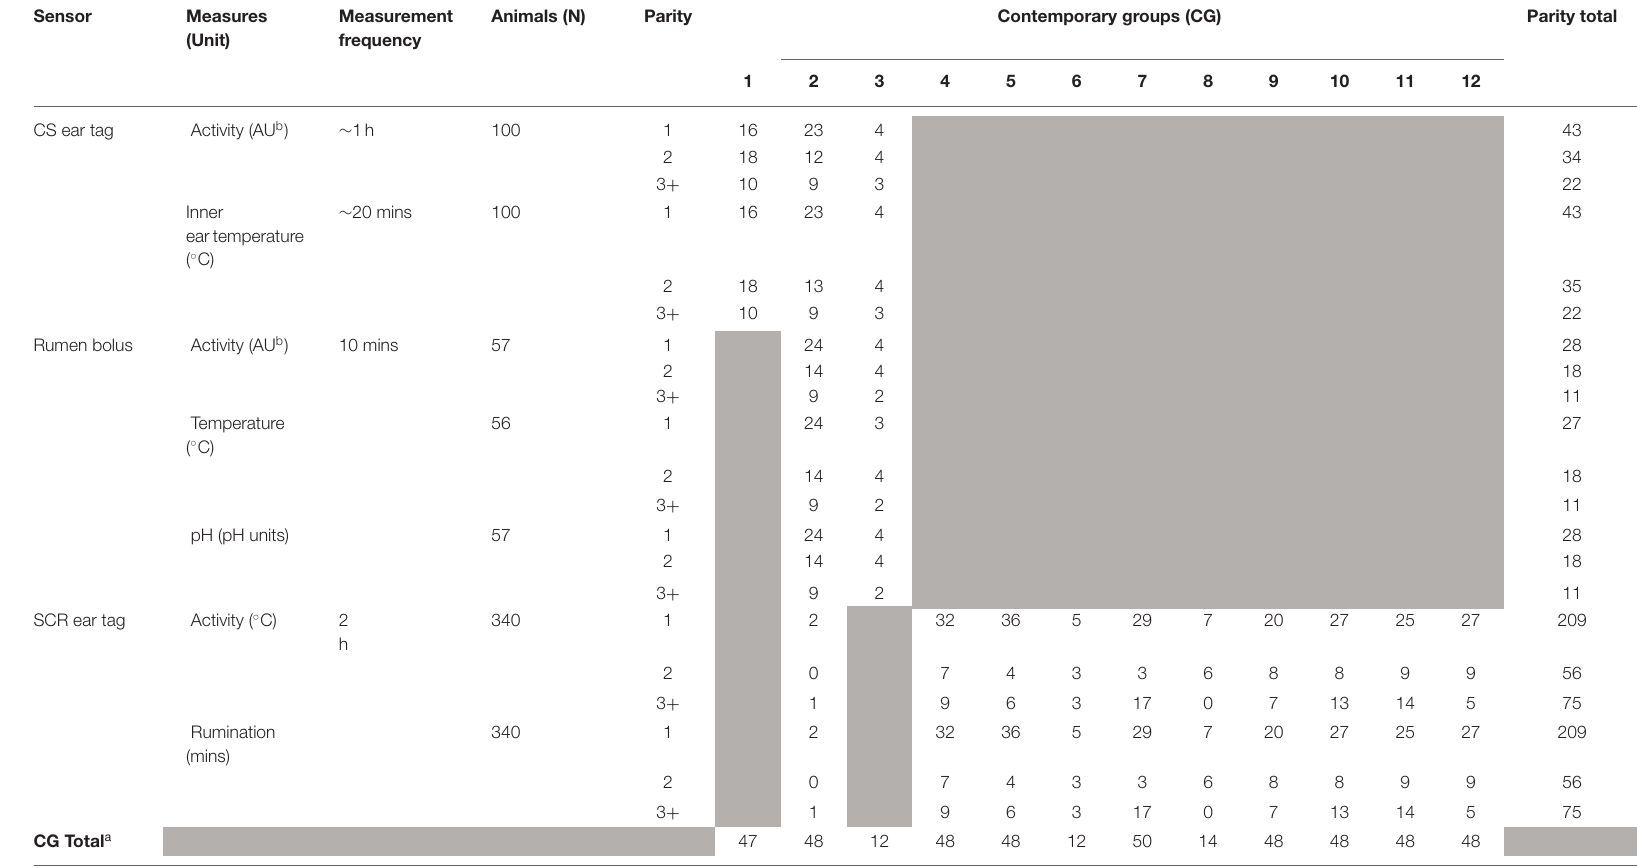
TABLE 1 | Summary of sensor information after data